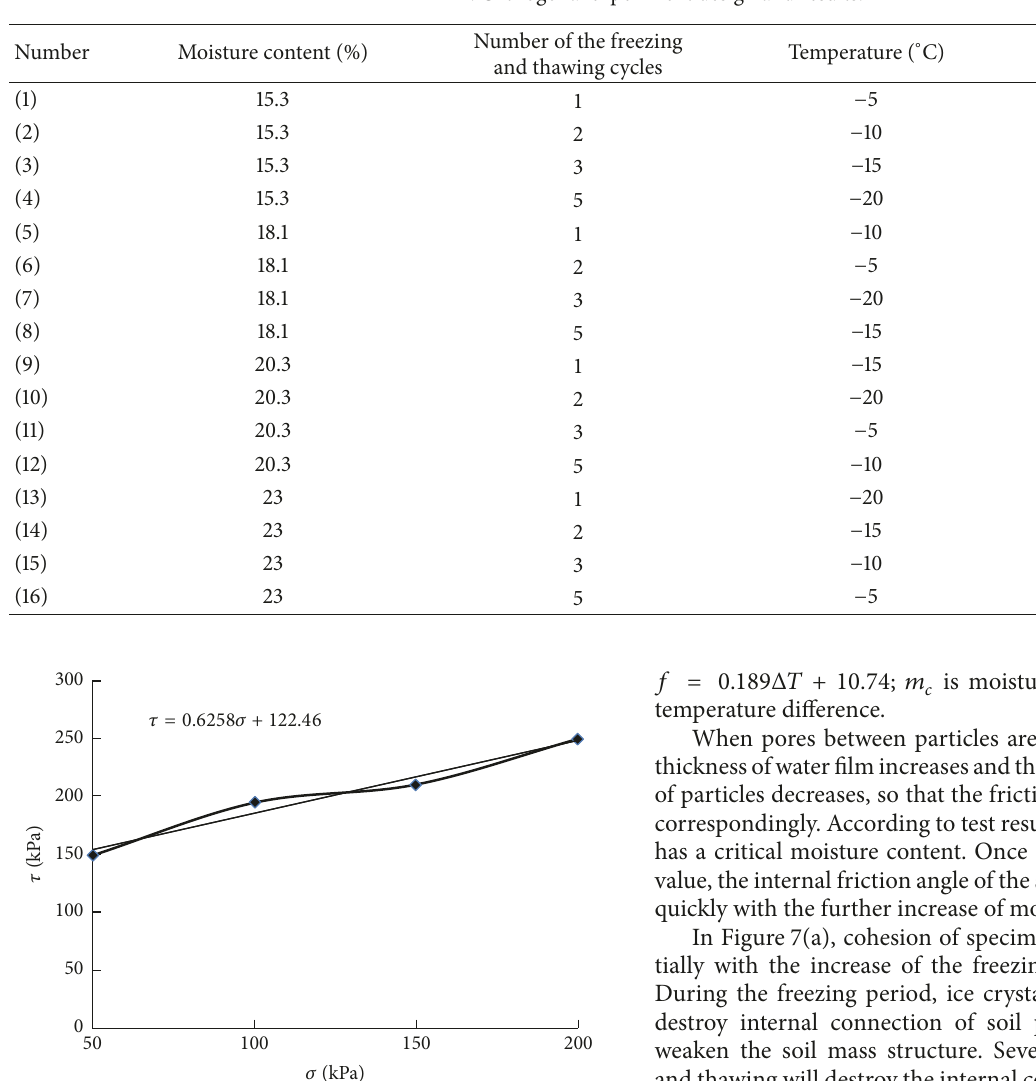
Table 1: Orthogonal experiment design and results.